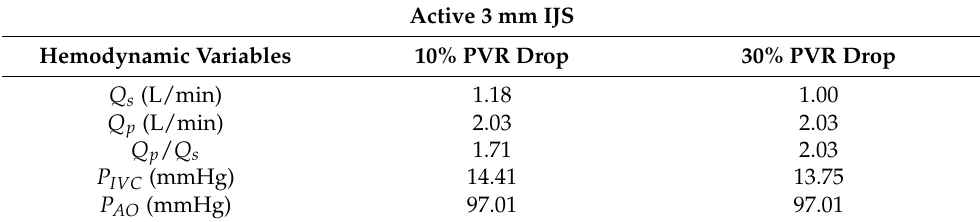
Table 5. Pressure and flow measurements for active IJS and decreasing